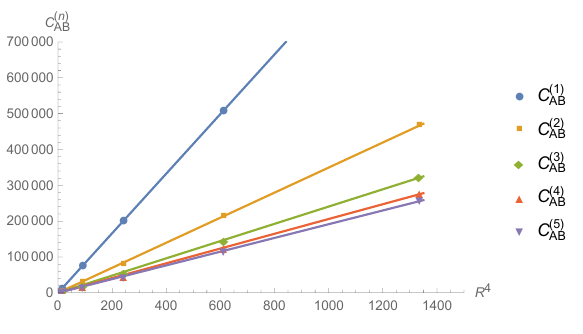
Figure 1 . The coe(cid:14)cient C ( n ) as a function of R 4 , where C ( n ) is the coe(cid:14)cient of the (R(cid:19)enyi) AB AB mutual information I ( n ) ( A; B ) of two spheres A and B whose radii are R A = R B (cid:17) R . The lines are the best linear